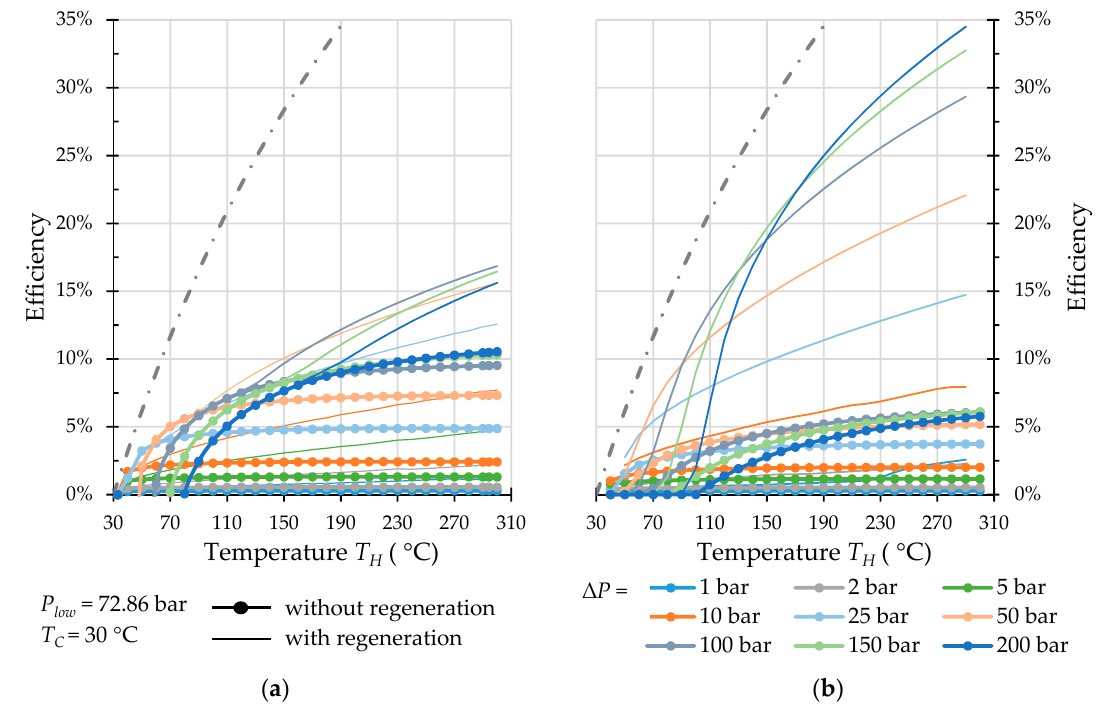
Figure 12. Efficiency of regenerative Worthington-type machine ( a ) and Bush-type machine ( b ) operated with carbon dioxide.